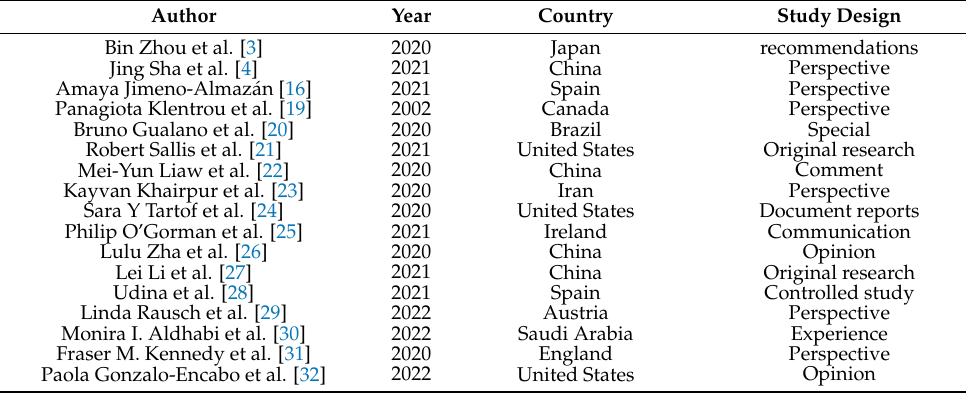
Table 1. Characteristics of included studies ( n = 41) and information about localization of papers findings in this narrative review.